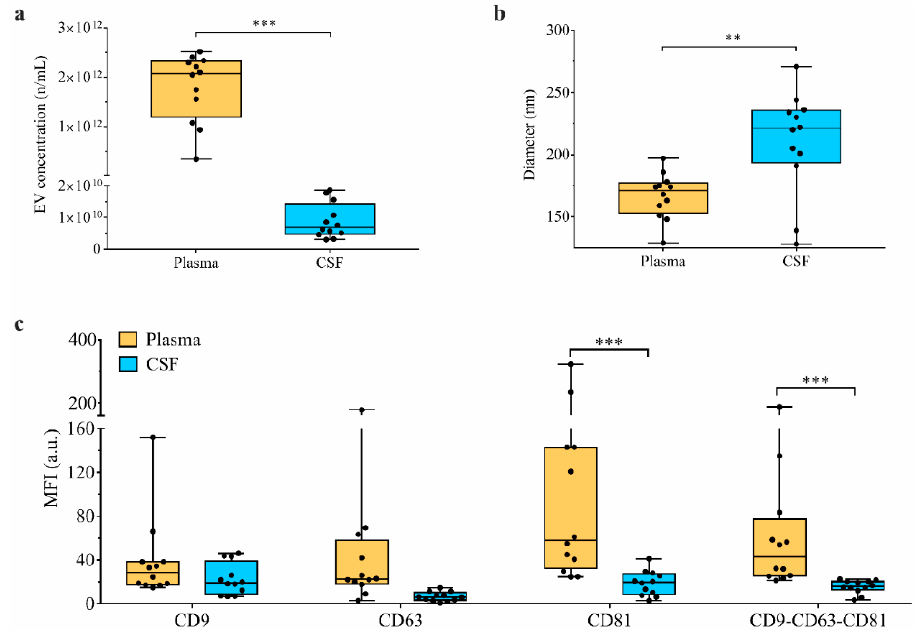
Figure 4. EV quantitative analysis: plasma vs. CSF. Quantitative analysis of extracellular vesicles (EVs) by nanoparticle tracking analysis (NTA) and MACSPlex assay flow cytometry; plasma samples were compared to paired cerebrospinal fluid (CSF) samples in patients with PD (Parkinson’s disease; n = 4), MSA (multisystem atrophy; n = 4) and AP-Tau (atypical parkinsonism with tauopathies; n = 4). ( a ) EV concentration (n/mL plasma or CSF) at NTA. ( b ) EV diameter (nm) at NTA. ( c ) MFI (expressed as arbitrary unity; a.u.) for CD9, CD63, CD81 and CD9-CD63-CD81 at flow cytometry. Boxplots show median and interquartile range; bars show minimum and maximum values (** p < 0.05; *** p < 0.001). Data and statistics are reported in Table S2.